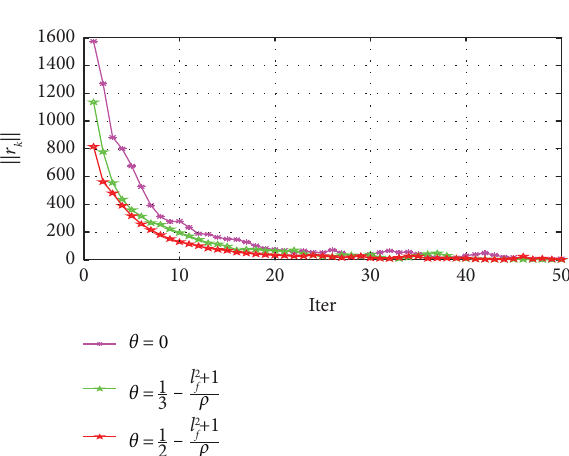
Figure 1: For ρ � 600and τ